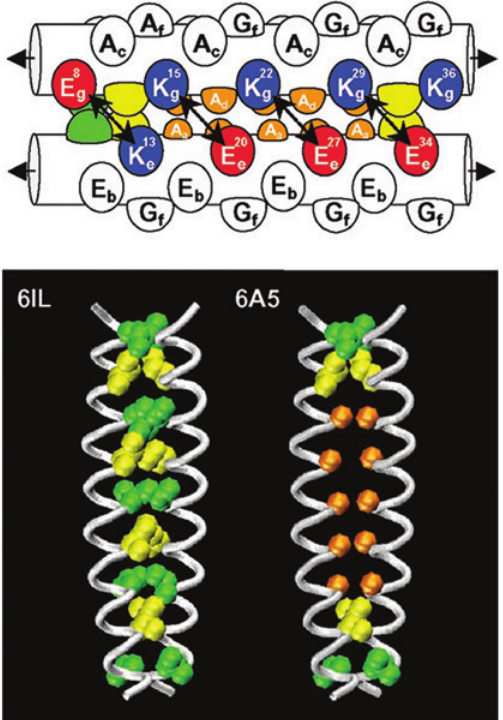
Figure 2: Models of coiled coils with either a stabilizing cluster (Ile, Leu) or a destabilizing cluster (Ala) in the hydrophobic core, which are also the clear and dark sides of